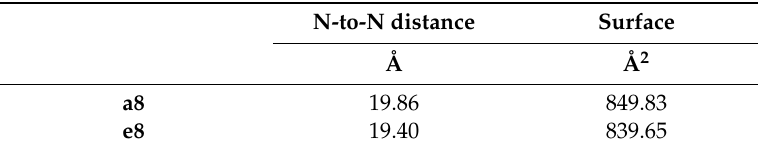
Figure 7. 3D models of optimised A : a8 and B : e8 gemini molecules. Table 4. Values of N-to-N longitudinal size and van der Waals surface of a8 and e8 hydrophilic molecule parts calculated by the OPLS force field using the Schrödinger Maestro software. N-to-N